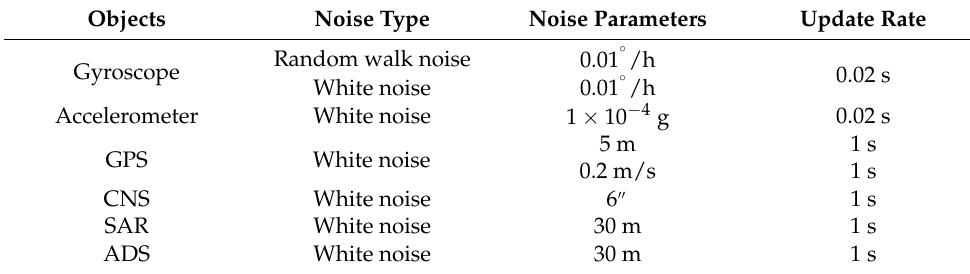
Table 2. Navigation sensor simulation parameters.